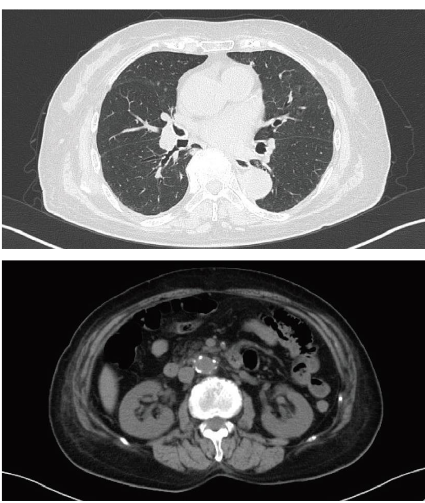
Figure 1: Plain CTof the chest and abdomen showing no fndings suggestive of pneumonia, and no abnormality in renal